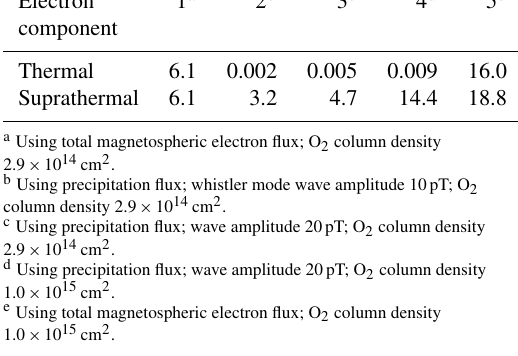
Table 3. Calculated intensities of OI1356Å emissions in Rayleigh due to magnetospheric electrons (Eq. 31).